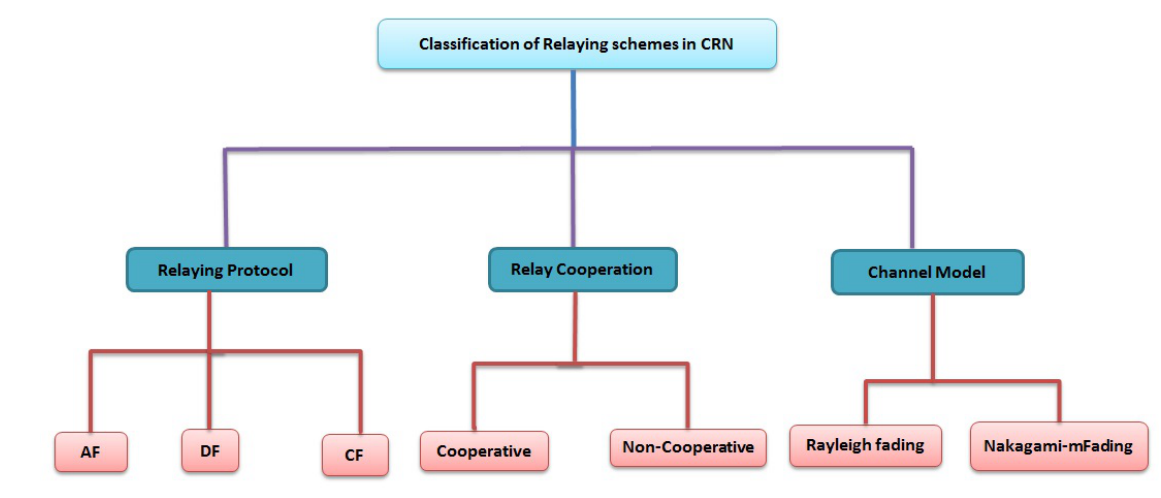
Figure 2. Classification of relaying in cognitive radio